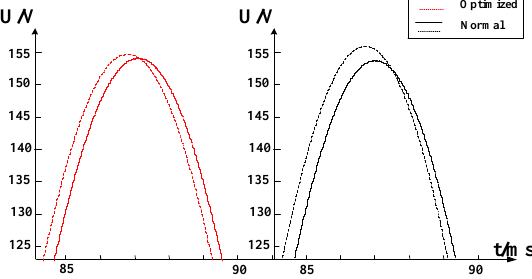
Figure 15. Partial enlargement of Figure 14 from 85ms to 90ms.